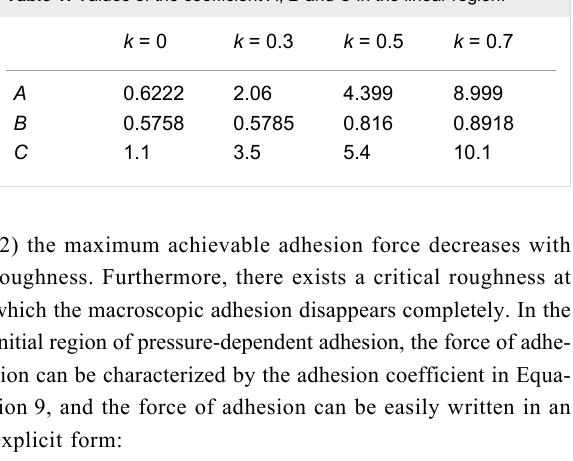
where α and β are